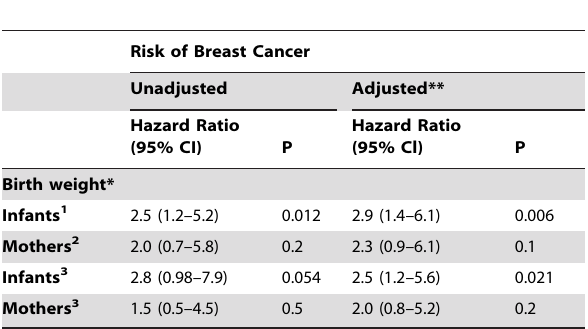
Table 2. Risk of Breast Cancer in Relation to Infants’ and Mothers’ Birth